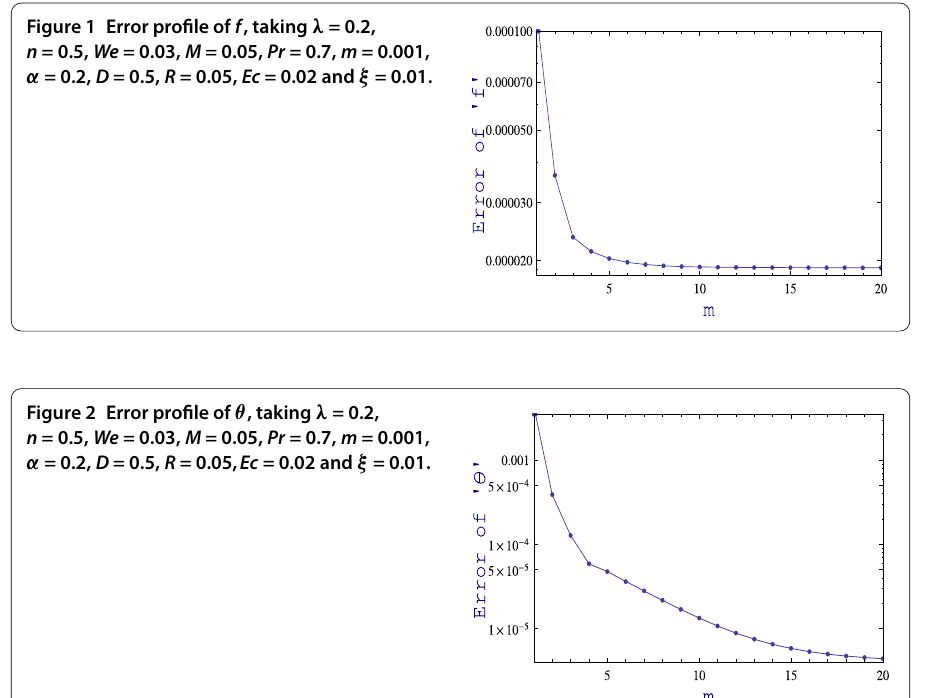
Figure 2 Error profile of θ , taking λ = 0.2, n = 0.5, We = 0.03, M = 0.05, Pr = 0.7, m = 0.001, α = 0.2, D = 0.5, R = 0.05, Ec = 0.02 and ξ =